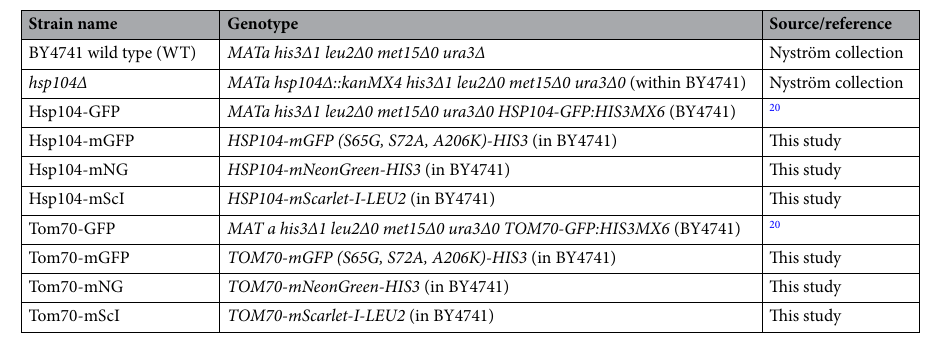
Table 1. List of yeast strains used in this study.